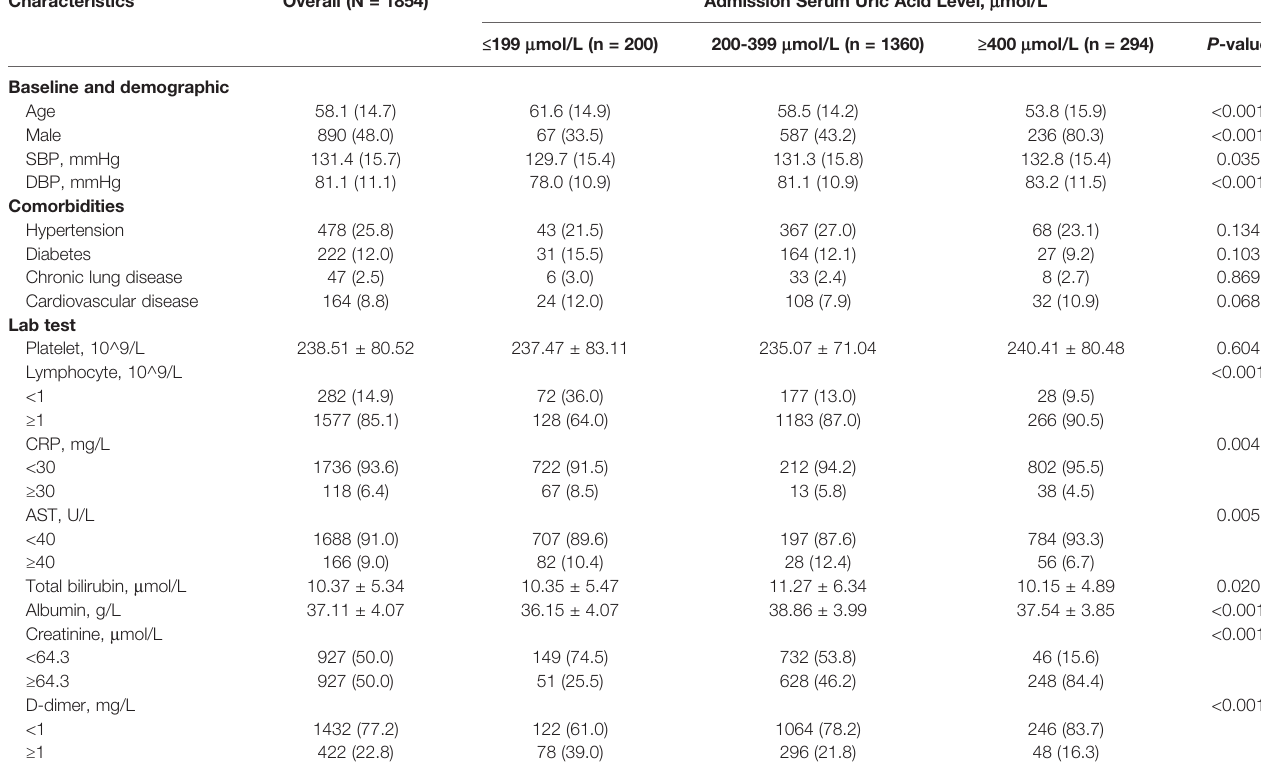
TABLE 1 | Baseline patient characteristics by serum uric acid concentrations. Characteristics